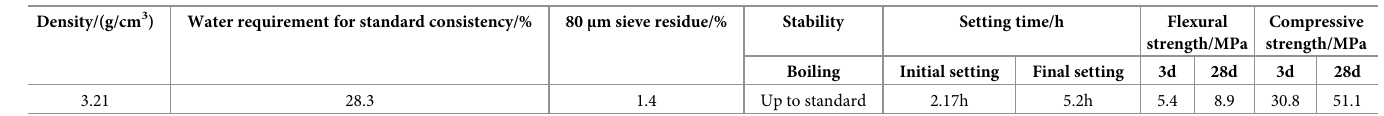
Table 1. Cement performance index parameters.